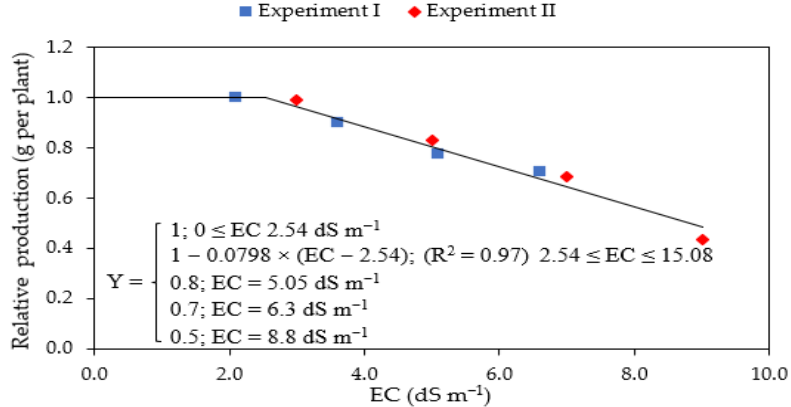
Figure 18. Relative production of ‘Canind é ’ okra cultivated in a hydroponic system as a function of the electrical conductivity of the nutrient solution (EC), described by the plateau followed by the linear decrease model proposed by [30], calculated considering the productions obtained at the EC of 2.1–6.6 dS m − 1 (Experiment I—blue squares) and 3.0–9.0 dS m − 1 (Experiment II—red